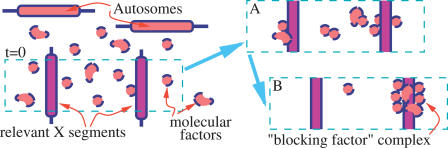
A Schematic Picture of Our ModelA random initial configuration of molecular factors, deriving from autosomes, surrounds two parallel and equally binding X chromosome segments relevant to XCI. Molecules have a reciprocal affinity, E
0, and can bind each other. As times goes on, particles form clusters (A), and if E
0 is larger than a given threshold value E
* (a value of the order of a weak hydrogen bond, see text) clusters coalesce into a single major complex attached to only one of the chromosomes (B).